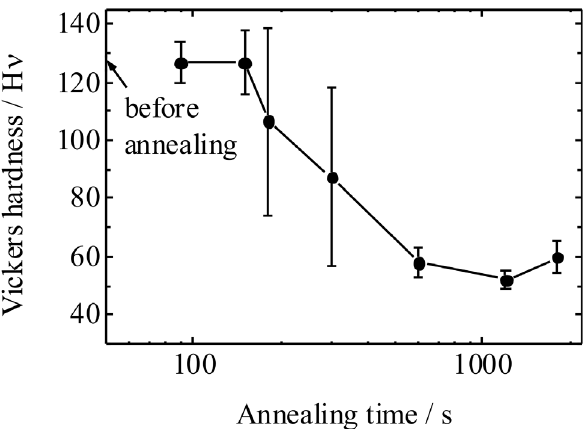
Figure 10: Variation in the Vickers hardness of the annealed 75% cold-rolled copper sheets at 473 K as a function of the annealing